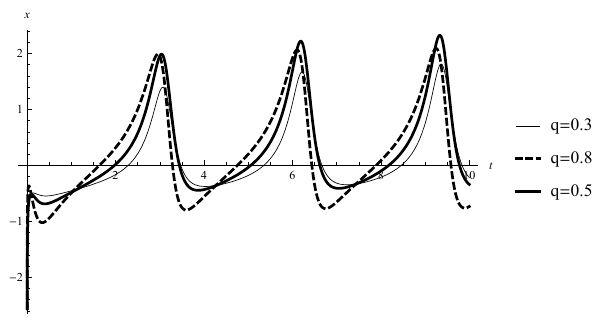
Figure 1. Example 2. Graph of the function g ( t ) + 0.1 for various values of q